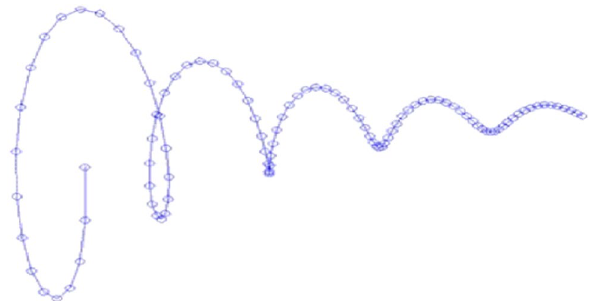
Fig. 11 Combined oscillatory nature of Z 1 and Z (27) The parameters for the affine transformation are modified according to Eq. (32) with 𝛿 satisfying Eq. (30). 𝛿 is a matrix of dimension ( 6 × 1 ) that is used to modify the matrix m e during every iteration.